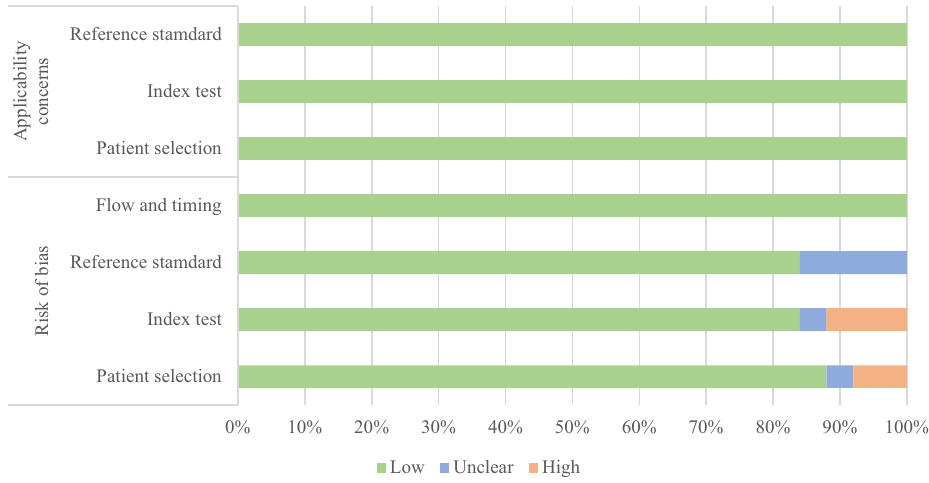
Figure 2. Quality assessment obtained using the QUADAS-2 instrument for the 23 selected